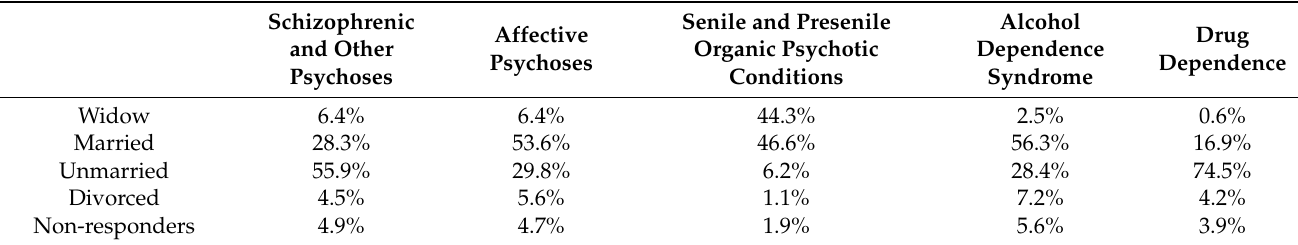
Table 7. Distribution of marital status among discharged patients with mental